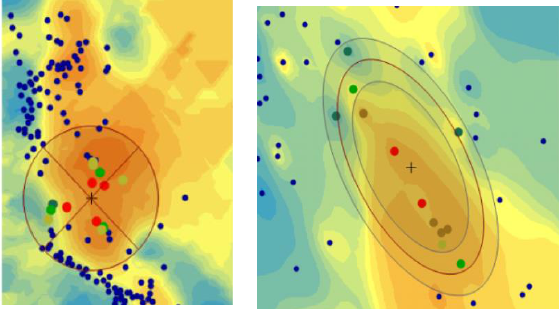
Figure 4. standard (left) and smoothing (right) search